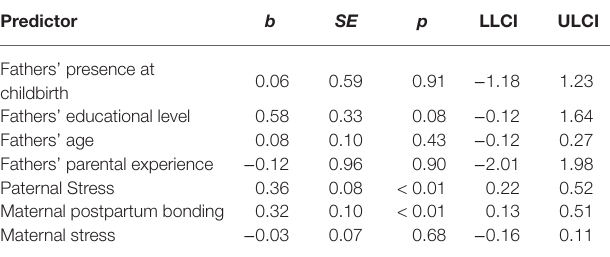
TABLE 3 | Results of regression analyses for Paternal Postpartum Bonding. Predictor b